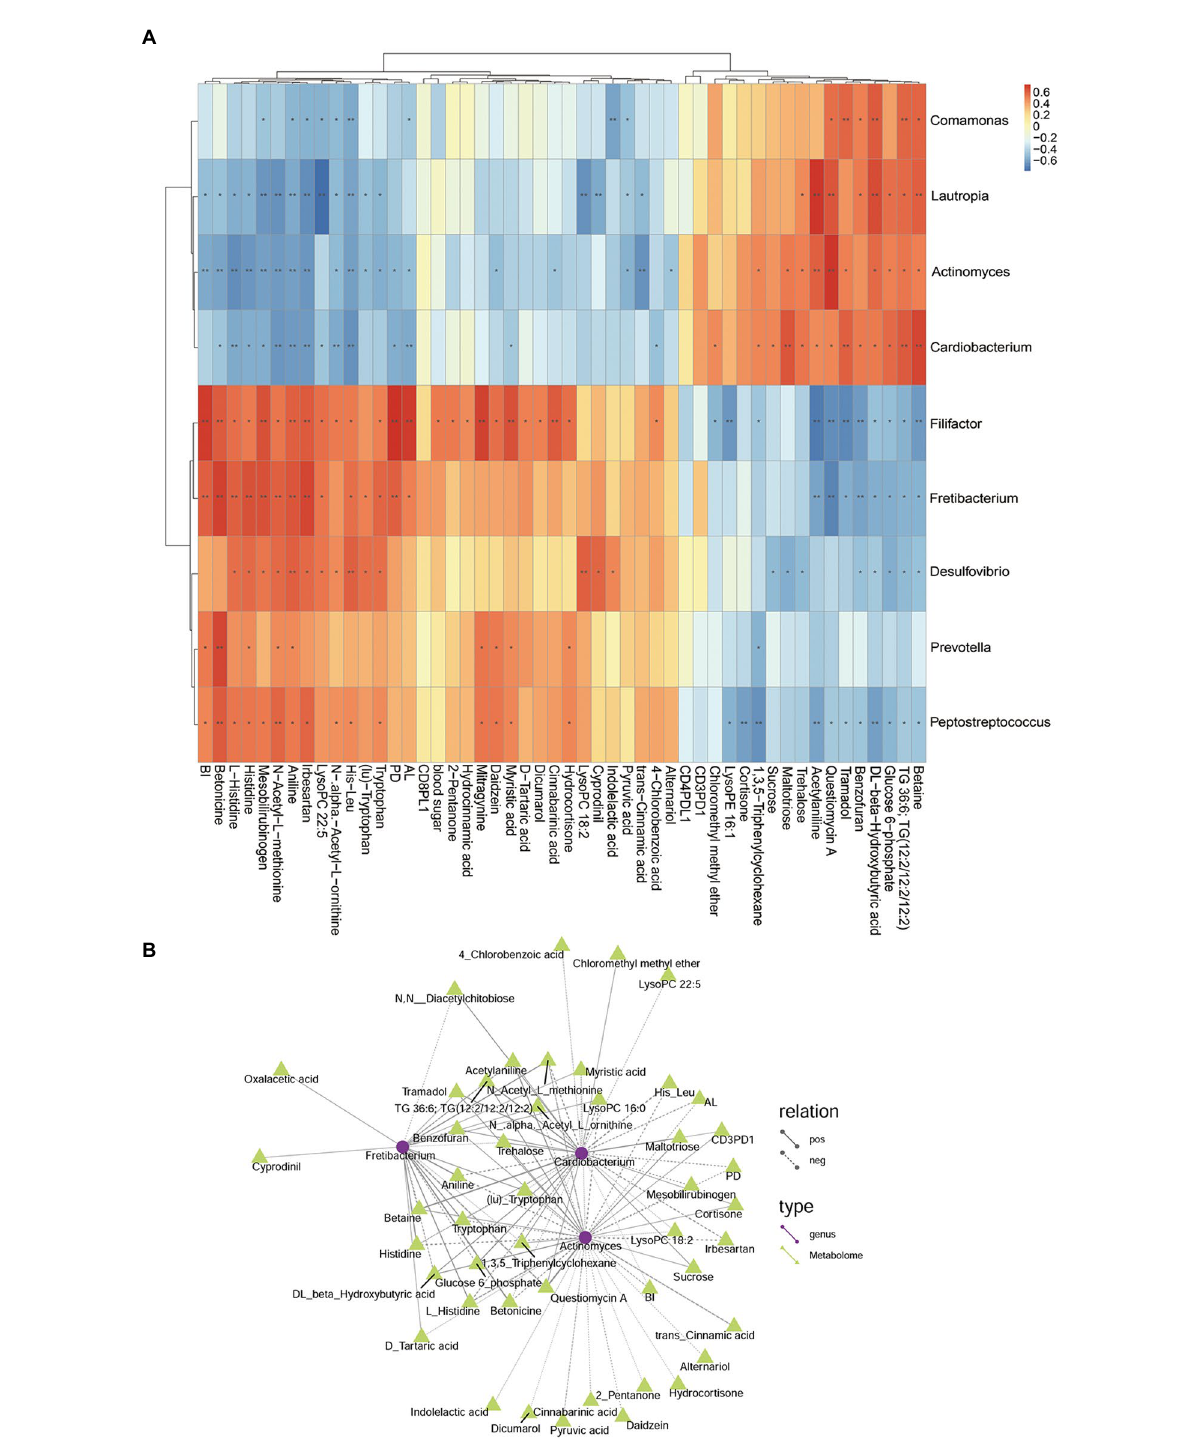
FIGURE 12 The relationship among genus, metabolites, and clinical index of DP and DNP groups. (A) Correlation between differential bacteria and metabolites, with clinical indicators. Red indicates positive correlation, blue indicates negative correlation (* p < 0.05, ** p < 0.001). (B) Network relationship among differential genera, metabolites, and clinical index of DP and DNP groups. The connection between the microbiota and metabolites represents a correlation between them; the solid line represents a positive correlation, and the dotted line represents a negative